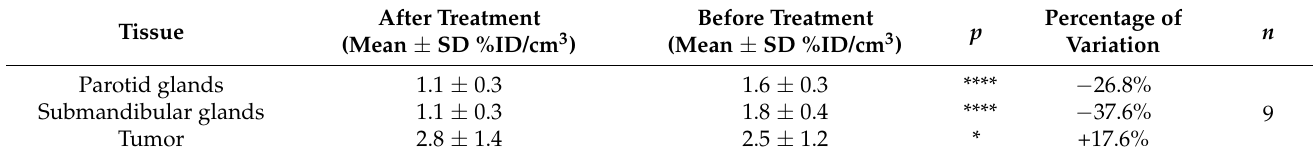
Table 4. Quantification of [ 68 Ga]Ga-PSMA-11 in the parotids, submandibular glands, and tumor in prostate-tumor-bearing mice. Statistical tests have been performed by two-way ANOVA followed